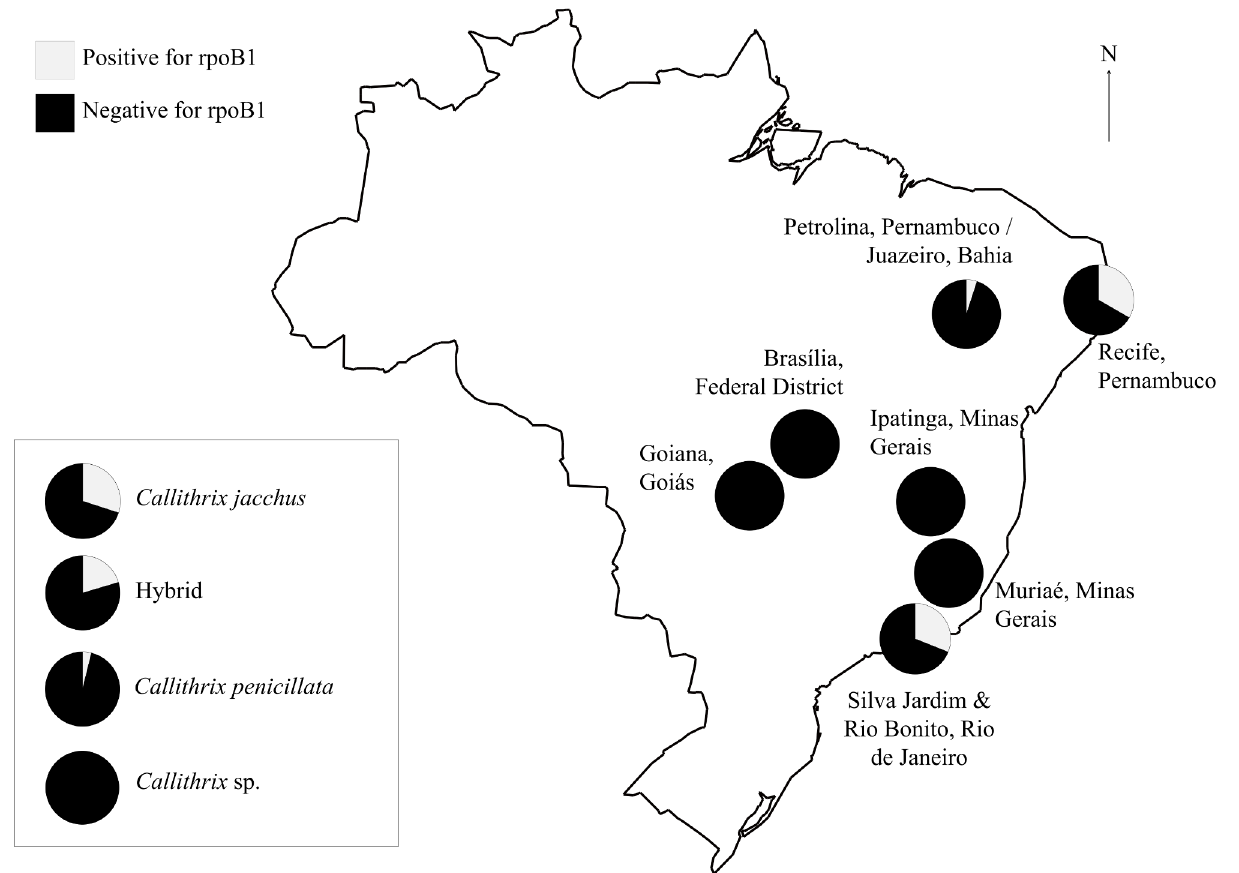
Fig 4. Distribution of mycobacteria identified in case study. Geographic and taxonomic distribution of rpoB1 positive marmoset samples. rpoB1 positive samples are found in Recife, Pernambuco (n = 4), the neighboring municipalities of Petrolina, Pernambuco and Juazeiro, Bahia (n = 1), and the neighboring cities of Silva Jardim and Rio Bonito, Rio de Janeiro (n = 9) and in C . jacchus (n = 3), hybrids (n = 10), and C . penicillata (n = 1).